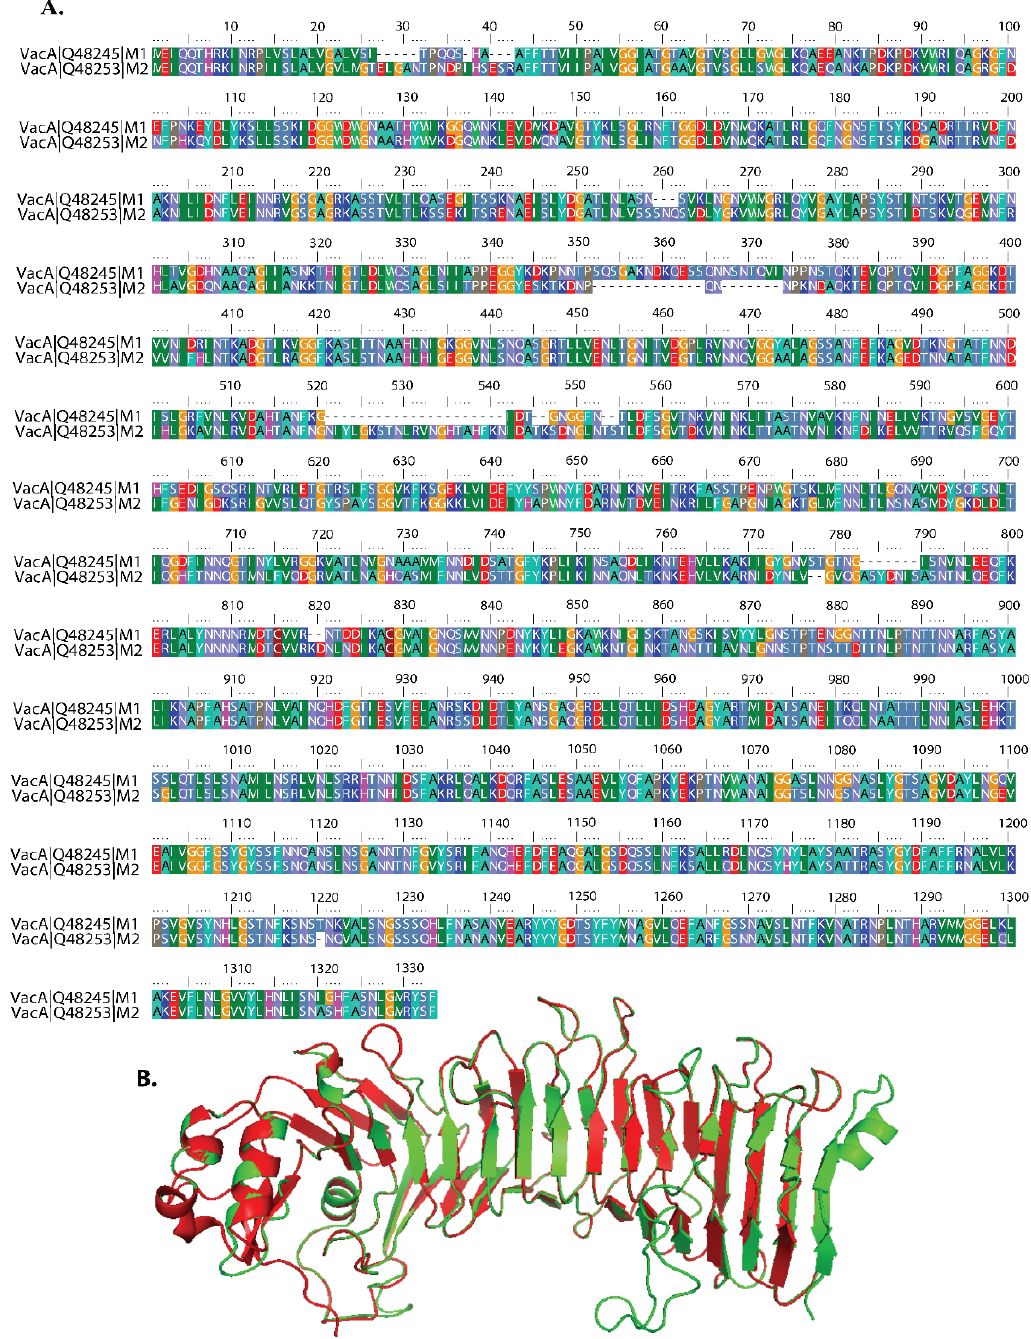
Figure 1. Sequence and structure of VacA isoform. ( A ) Comparison of amino acid sequences of M1 and M2 isoforms of VacA protein of Helicobacter pylori . Corresponding accession nos. Q48245 ( H. pylori strain 60190, m1 VacA) and Q48253 (strain Tx30a, m2 VacA). Amino acid color code generated by ClustalW within BioEdit software was used. Consensus residues ("Clustal cons" line) were generated by ClustalW. The numbers at the beginning and end of each line are for reference only and do not correspond to the original numbers of individual amino acid sequences recorded in published reports. Hyphens indicate gaps in the alignment at that position. ( B ) The ribbon image shows the superimposition of the I-TASSER modelled m1 protein (green color) with m2 protein (red color).